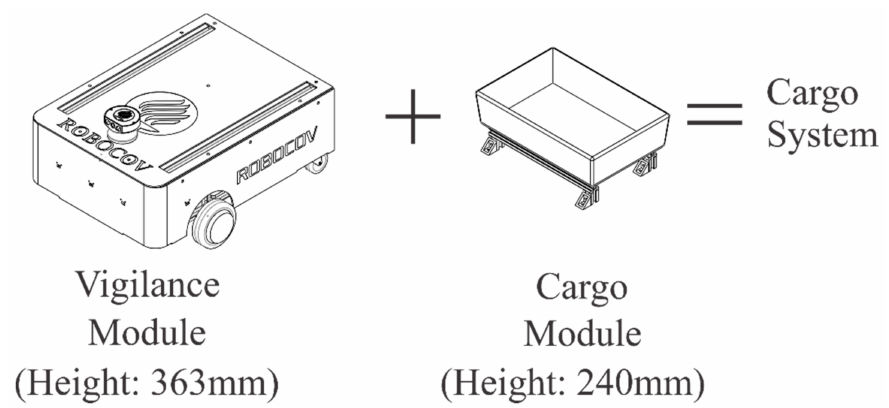
Figure 19. Cargo system.